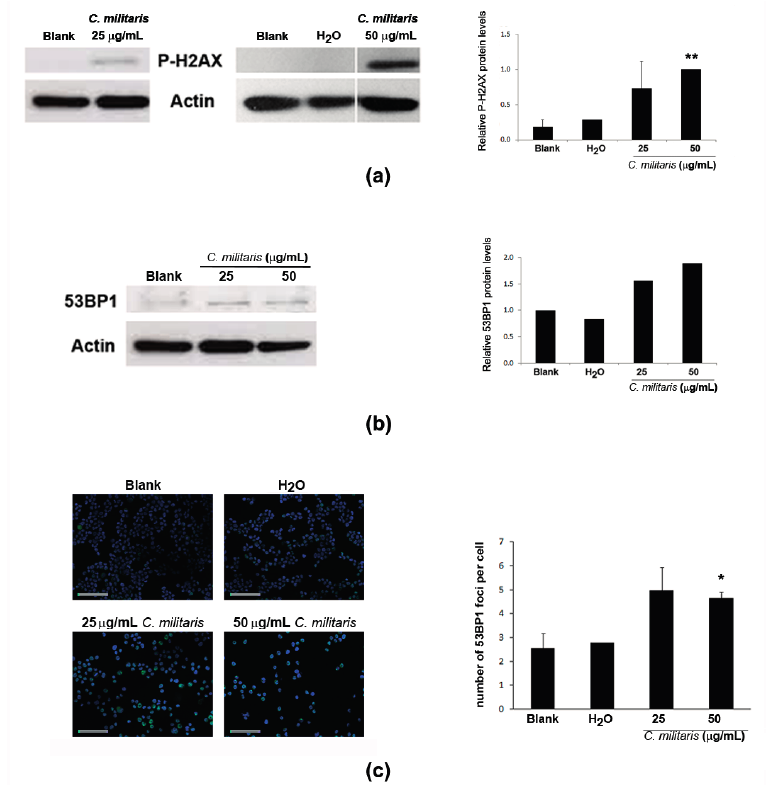
Figure 4. Effect of treatment with C. militaris methanolic fruiting body extract in NCI-H460 cellular DNA damage. Cells were treated for 48 h with complete medium (Blank), 25 μ g/mL or 50 μ g/mL extract or with the highest vehicle (H 2 O) concentration. ( a ) Analysis of the expression of P-H2AX by Western blot. Actin was used as loading control. Left Panel: Representative images. Right Panel: Densitometry analysis of the Western blots. Results are expressed after normalization of the P-H2AX values with the values for actin and further expressed in relation to treatment with 50 μ g/mL extract. Results are the mean ± SEM of, at least, three independent experiments (except for solvent control (H 2 O) which results from two experiments only); ( b ) Analysis of the expression of 53BP1 by Western blot. Actin was used as loading control. Left Panel: Representative images. Right Panel: Densitometry analysis of the Western blots. Results are expressed after normalization of the 53BP1values with the values for actin and further expressed in relation to blank. Results are the mean of two experiments only; ( c ) Analysis of the number of 53BP1 foci per cell. Left Panel: Representative fluorescence microscopy images of 53BP1 foci ( green ) and DAPI stained nuclei ( blue ). Bar corresponds to 20 μ m. Right Panel: Quantification of 53BP1 foci. Results are the mean ± SEM of three independent experiments (except for the control (H 2 O), which results from two experiments only). * p ≤ 0.05 and ** p ≤ 0.01 blank vs.